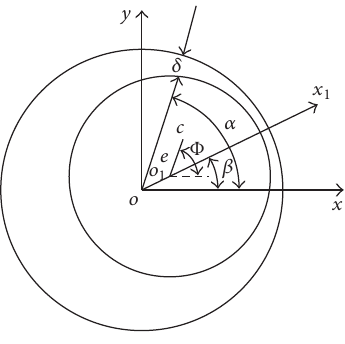
Figure 3: Air gap eccentricity of the rotor in motorized